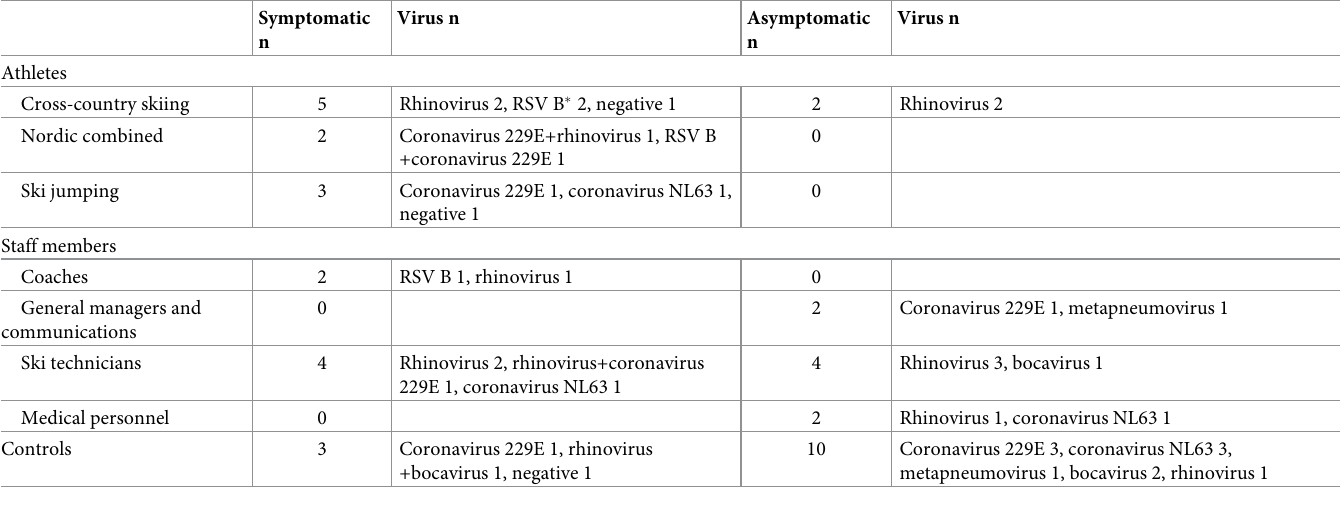
Table 4. Symptomatic and asymptomatic respiratory viral infections in Team Finland and the